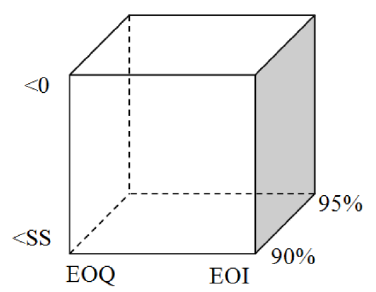
Figure 3. DoE: Factorial sub-plan